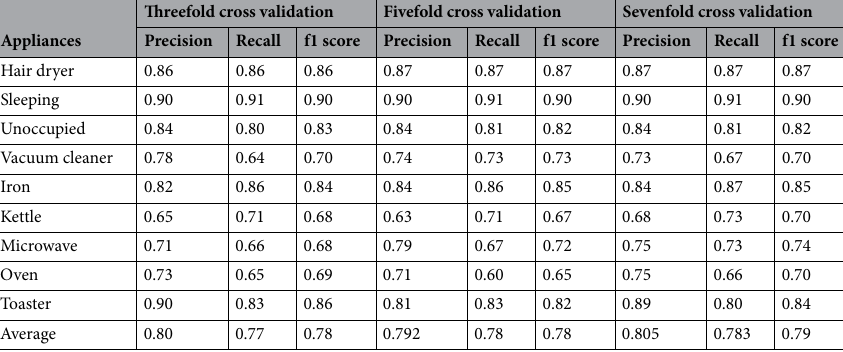
Table 7. Performance evaluation for case 3 with three, five, and sevenfold cross-validation.